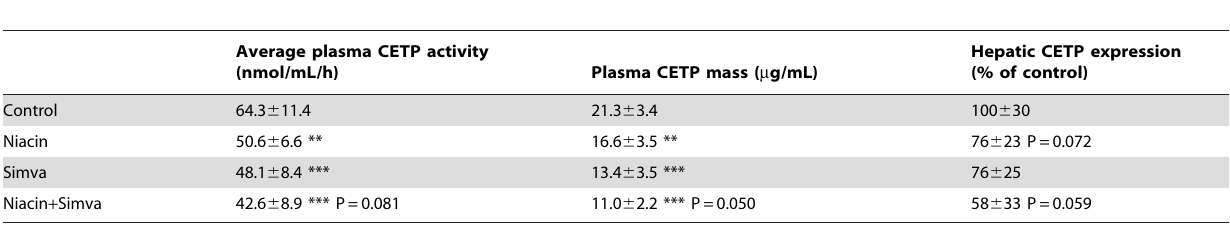
Table 1. The effect of niacin, simvastatin and their combination on plasma CETP activity after 4 and 18 weeks of treatment, as well as plasma CETP mass and hepatic CETP expression after 18 weeks of